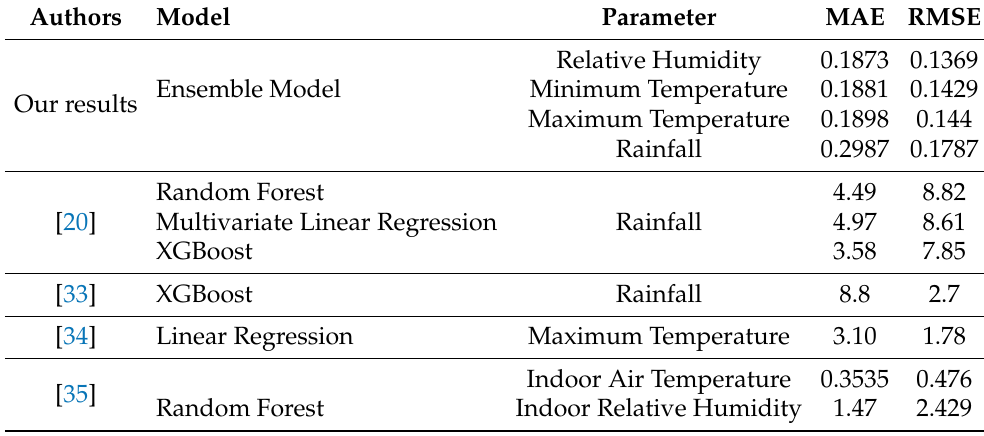
Table 6. Summary of our results and results from other